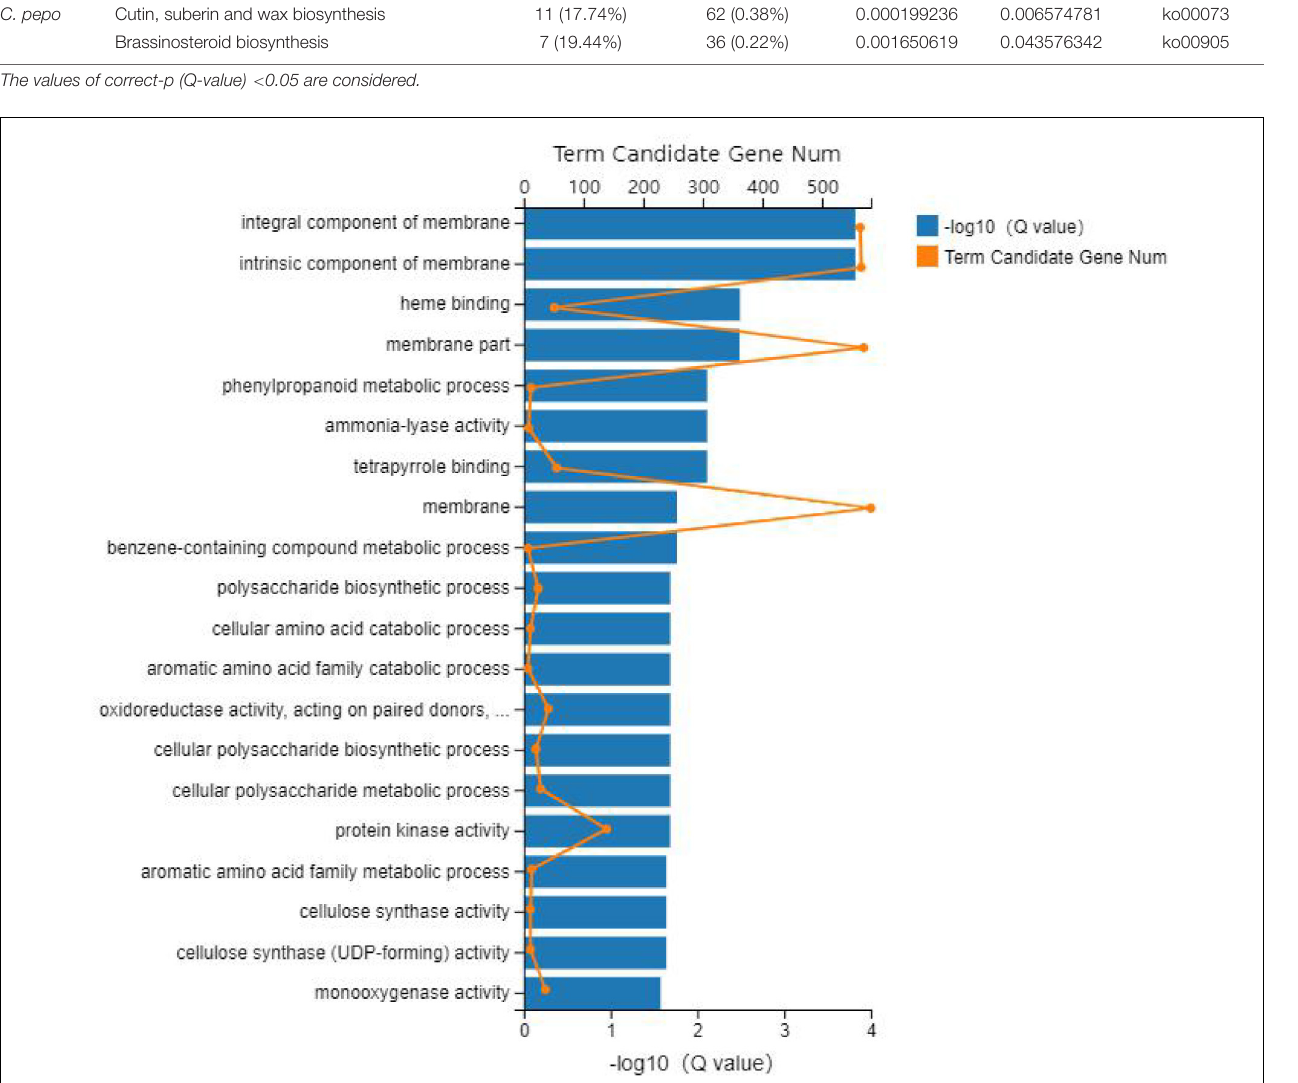
gene (cmach04g008740), the expression levels of which were 9.48-, 24.17-; 3.51-, 18.78-; 0.99-, 7.49-; 8.82-, 7.11-; and 3.65-, 7.09- fold times, respectively, in the CP variety higher than those in the HLCP variety after 18 days and 28 days of pollination.